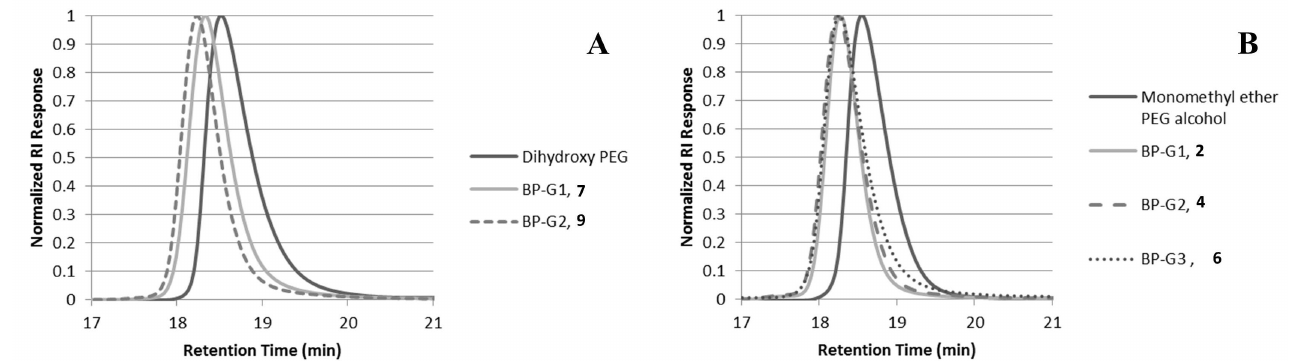
FIGURE 3 - a) GP chromatogram of benzylidene-protected dendritic-linear-dendritic triblocks. b) GP chromatogram of benzylidene- protected linear-dendritic